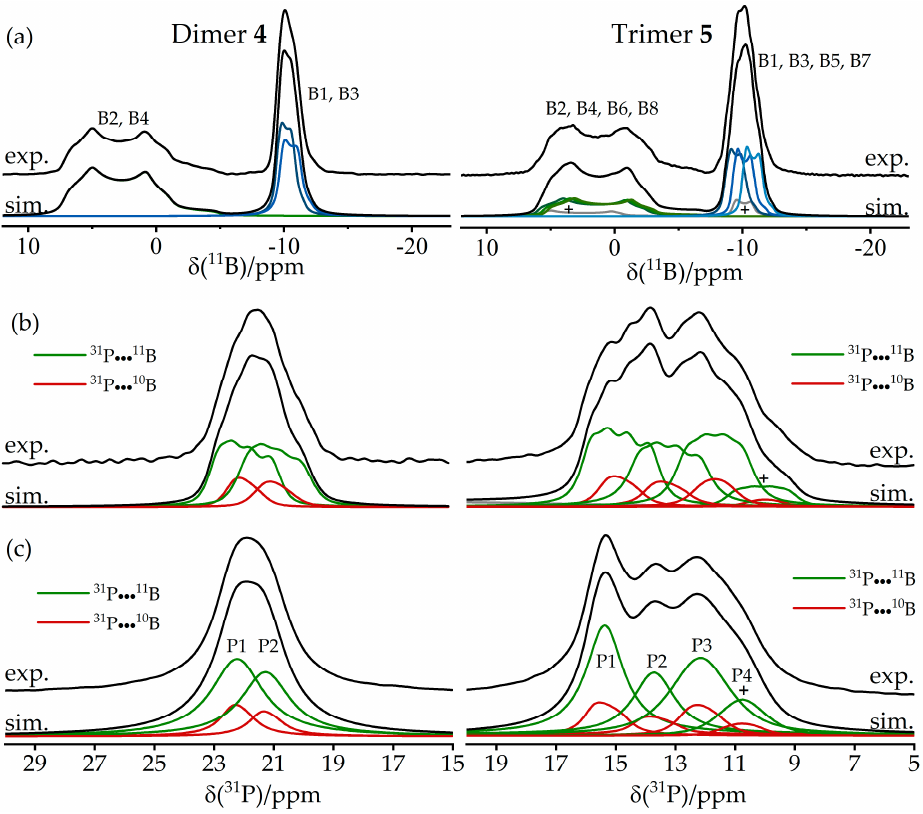
Figure 19. Experimental and simulated ( a ) 11 B MAS, ( b ) 31 P MAS, and ( c ) 1 H → 31 P{ 11 B dec} CP / MAS NMR spectra of the B/P FLP–CO dimer 4 and trimer 5 . Simulated 31 P MAS NMR spectra include the individual contributions for 11 B (green) and 10 B (red) isotopologues. Note the effect of 11 B decoupling suppressing the multiplet structure due to 31 P– 11 B indirect spin–spin coupling in (c). Impurities are marked with a cross. In (a) the signals labeled B7 and B8 originate from an impurity.